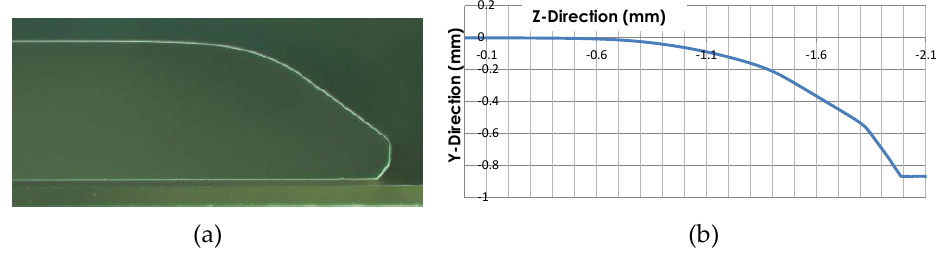
Figure 8. (a) Cross-sectional view of reflection surface 1 of the cover glass. (B) Using UA3P measurement results, the angle of reflection surface 1 is 39.09 degrees.